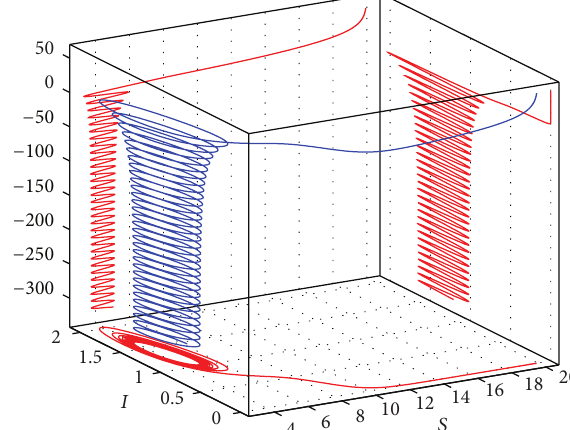
Figure 4: Phase trajectory in system (3) by fixed 𝐴 = 2, 𝑑 = 0.1, 𝛽 = 0.8, 𝑏 = 2.4, 𝜖 = 0.6, 𝛾 = 0.2, 𝑎 = −0.13